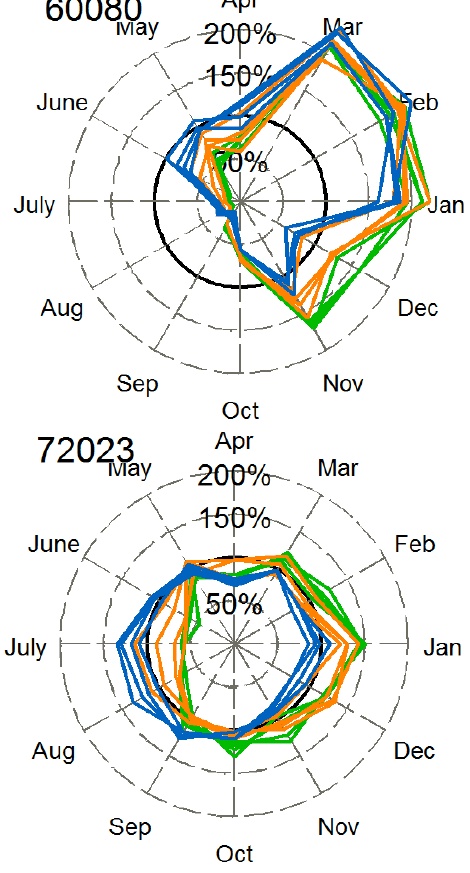
Fig. 2. Relative frequency of events (by calendar month) for 60080, Comboyne South (left) and 72023, Hume Reservoir (right). Colour denotes duration: green – short durations (6, 12, 18, and 30min), orange – intermediate durations (1, 2, 3, and 6h), blue – long dura- tions (12, 24, 48, and